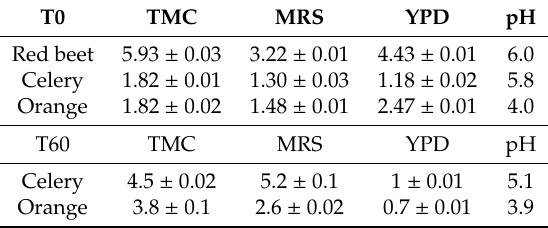
Table 2. Plant derived juices’ microbial cell load for yeast (YPD), lactic acid bacteria (MRS) total microbial count (TMC), and pH of fermented and unfermented juices. Counts are expressed as log CFU /